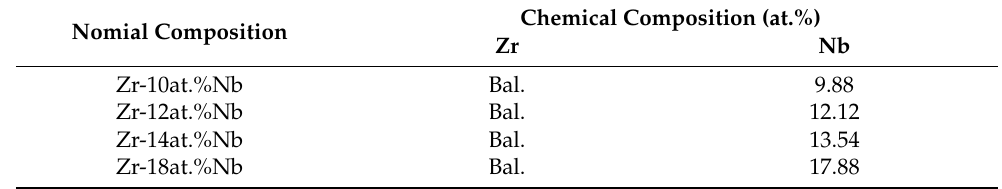
Table 1. Chemical composition of Zr-x at.% Nb (x = 10, 12, 14, and 18) alloy master ingots. Nomial Composition